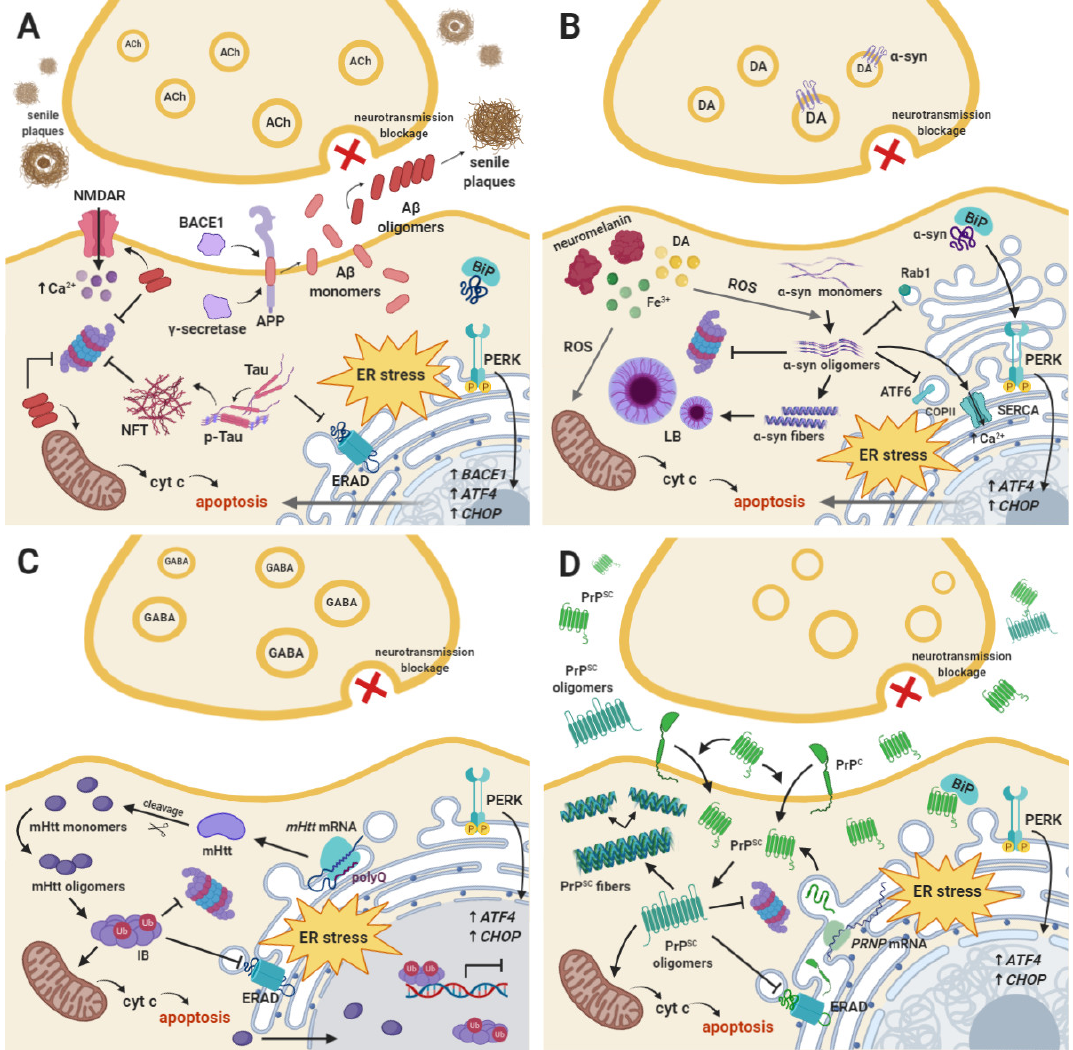
Figure 1 . The schematic view of molecular perturbances resulting in subsequent activation of the protein kinase RNA-like endoplasmic reticulum kinase (PERK)-dependent unfolded protein response (UPR) signaling pathway in the following neurodegenerative disorders: ( A ) Alzheimer’s disease (AD), ( B ) Parkinson’s disease (PD), ( C ) Huntington’s disease (HD), and ( D ) prion disease. More details are included in the text of the manuscript.